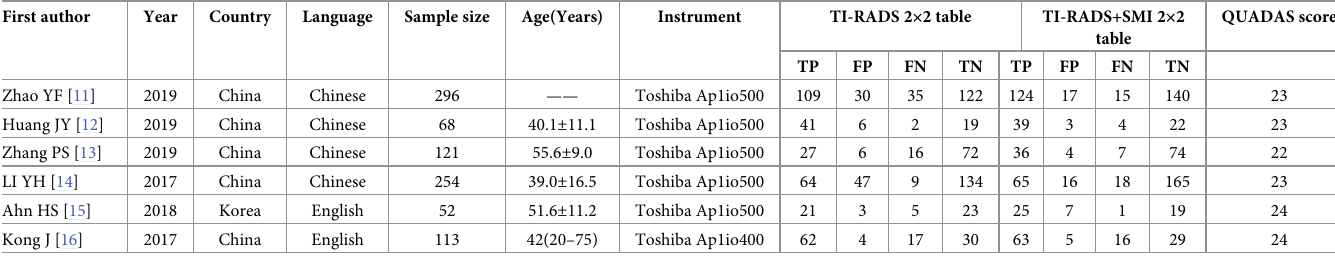
Table 1. Baseline characteristics and methodological quality of all included studies.